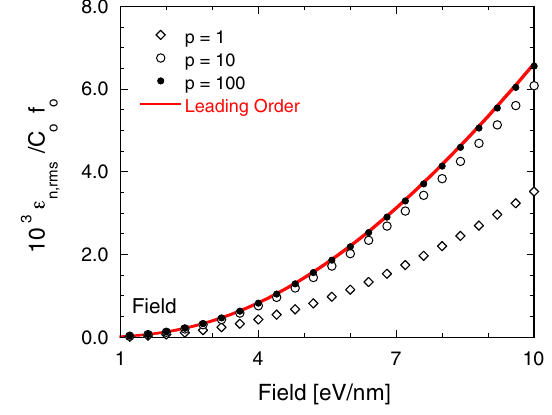
FIG. 8. Same as Fig. 6 but for parameters typical of field emission in Table III.